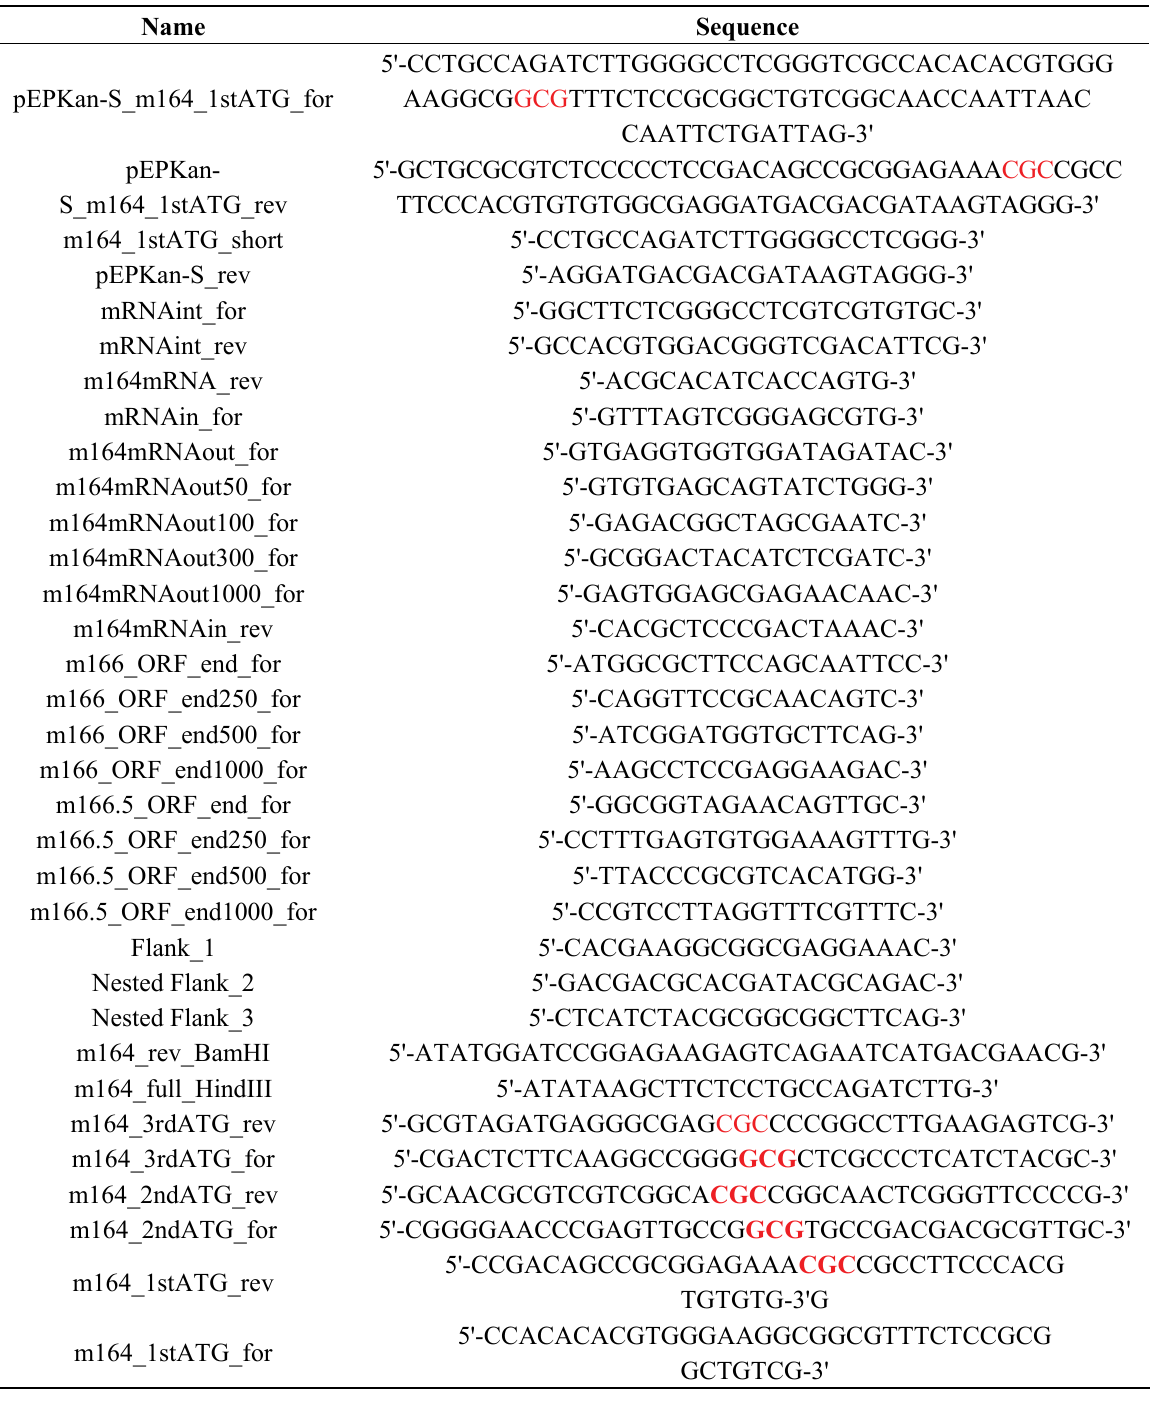
Appendix Table A1. Oligonucleotides used in this study; nucleotides inserting ATG to GCG substitutions are highlighted in bold face red